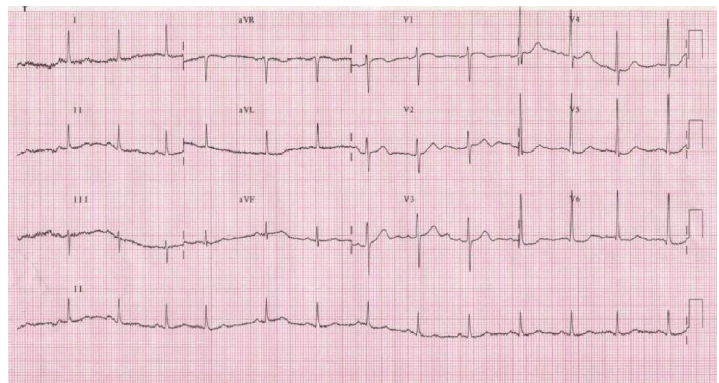
Figure 5: Surface ECG performed at high-dose dipyridamole during stress echocardiography after 6-month therapy with ranolazine. At the same time the patient was completely asymptomatic.